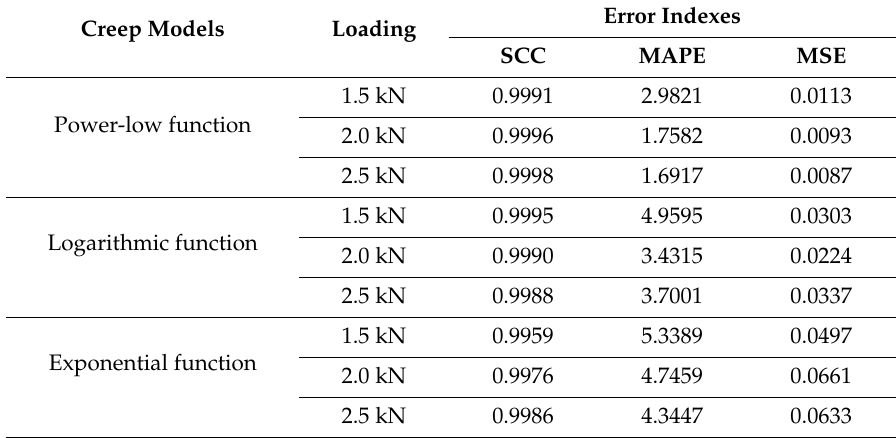
Table 1. Error analysis of di ff erent creep damage functions ( T = 23 ◦ C).